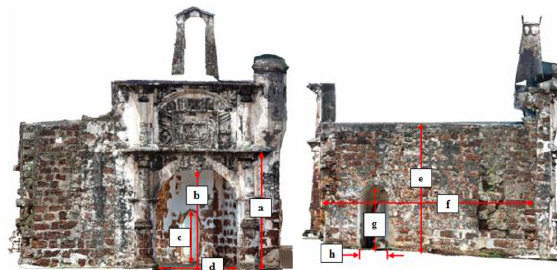
Figure 8. Measurements taken from A'Famosa façade